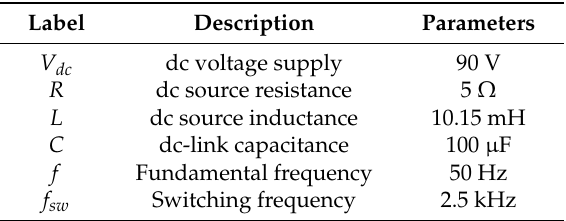
Table 1. Simulation circuit and experimental setup parameters.